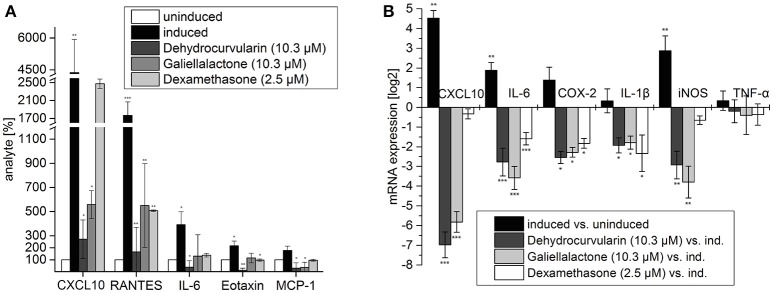
Multiplex ELISA of culture supernatants from adult ENS networks (A) and qRT-PCR analysis of pro-inflammatory transcripts in adult ENS networks (B) after treatment with the anti-inflammatory compounds galiellalactone and dehydrocurvularin. Cells were pretreated for 1 h with the indicated concentrations of test compounds prior to stimulation with CM for 24 h. Multiplex ELISA: The data are presented in comparison to untreated control cells (±SD). The untreated control cells correspond to 100%. n = 3 for the test substances galiellalactone and dehydrocurvularin, n = 2 for the positive control dexamethasone. *p < 0.05; **p < 0.01; ***p < 0.001 treated cells vs. cytokine induced cells. qRT-PCR: Induced vs. uninduced samples and treated vs. induced samples are shown. Results were normalized to GAPDH, n = 5. The data are presented as log2 ratios in comparison with cytokine induced control cells (±SD). *p < 0.05; **p < 0.01; ***p < 0.001 treated tissue vs. cytokine induced cells.